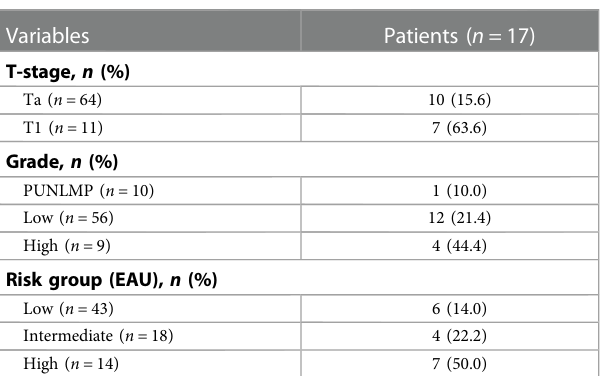
TABLE 3 The recurrence rate of different subgroups of patients.